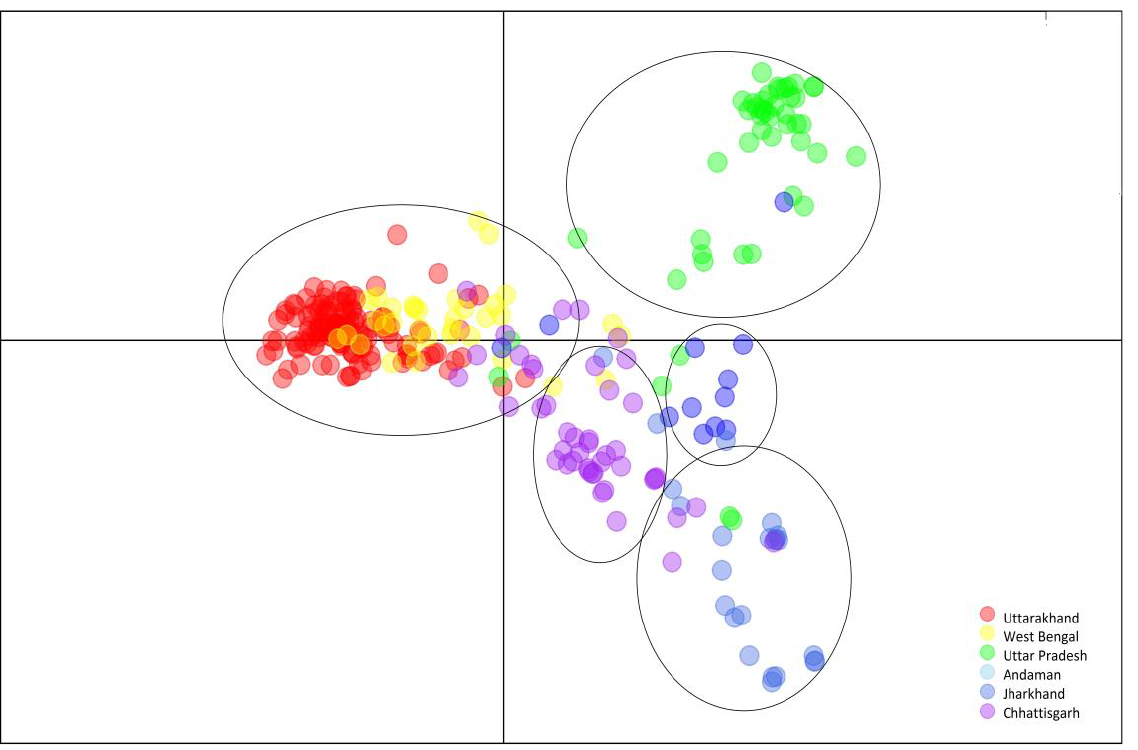
Figure 7. Discriminant analysis of principal components (DAPC) plot of 298 rice landraces showing five clusters with SNP markers.